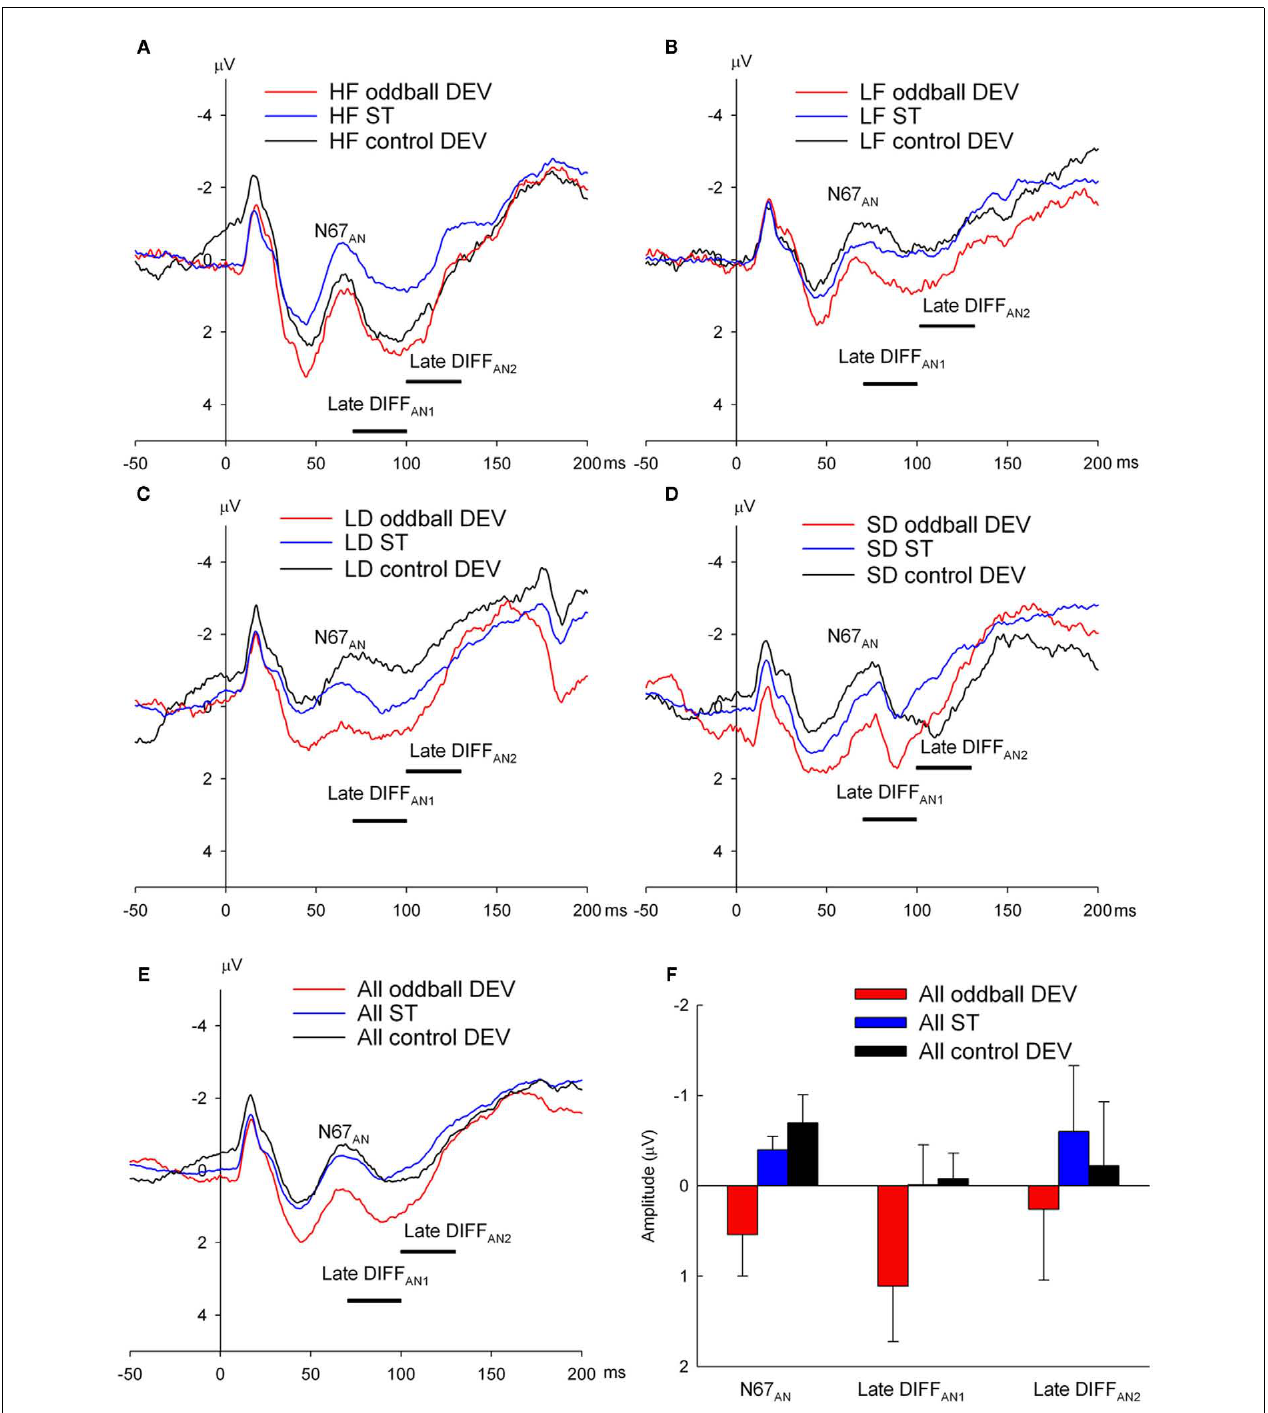
DEVs show a positive shift relative to STs and control DEVs. (E) ERPs obtained by averaging over all stimulus conditions to produce averaged oddball DEV, ST, and control DEV ERPs providing a depiction of the positive displacement of oddball DEVs relative to STs and control DEVs. (F) Mean amplitudes (with SEs) of N67 AN , late DIFF AN1 and late DIFF AN2 generated by oddball DEVs (red), STs (blue) and control DEVs (black) showing that N67 AN and late DIFF AN1 are both more positive than STs ( p = 0.046) and control DEVs ( p =